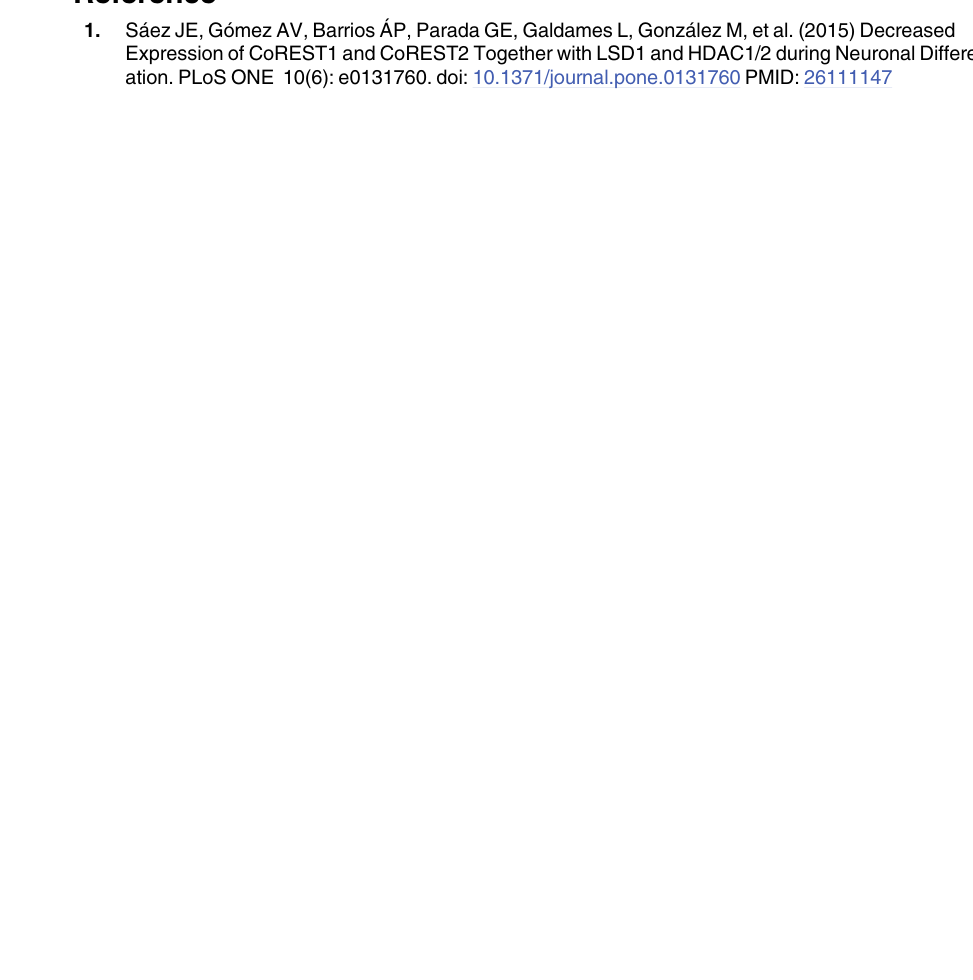
ation. PLoS ONE 10(6): e0131760. doi: 10.1371/journal.pone.0131760 PMID: 26111147